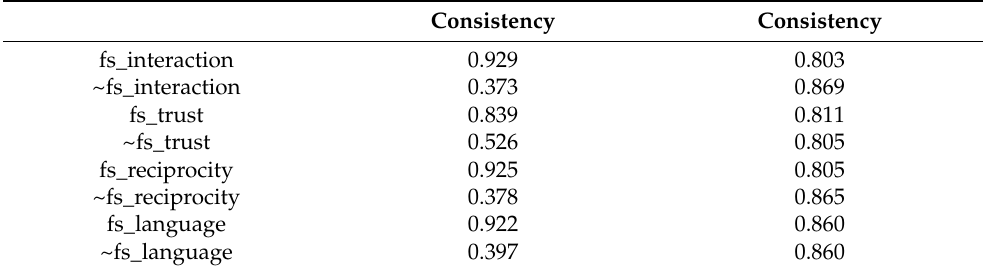
Table 4. Analysis of necessary conditions for purchase intentions in